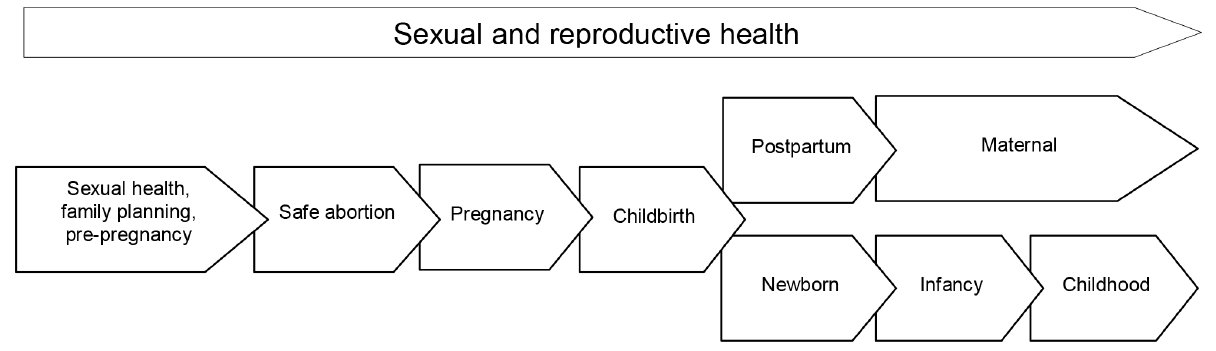
Figure 2. Continuum of sexual and reproductive health and maternal, newborn, child, and adolescent health.